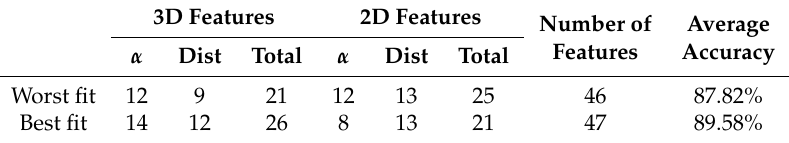
Table 10. Description of features and accuracy for the best and the worst fits.